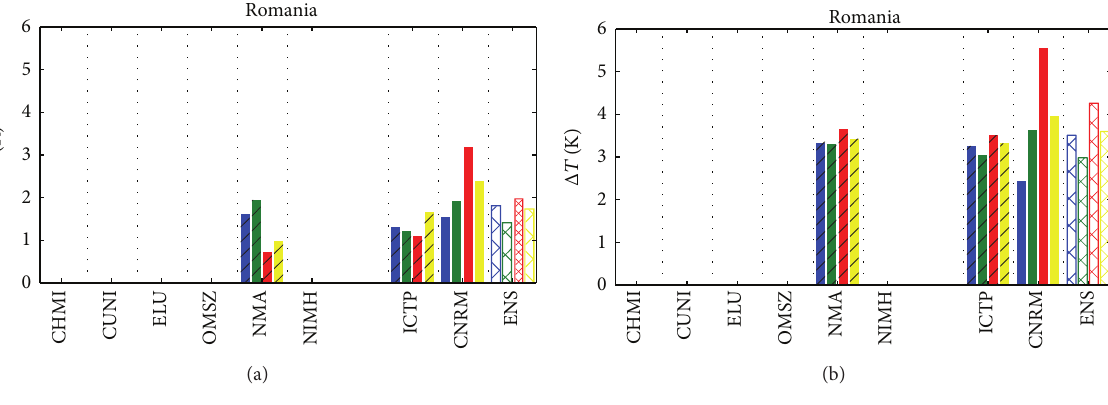
Figure 6: As Figure 3 for Romania.